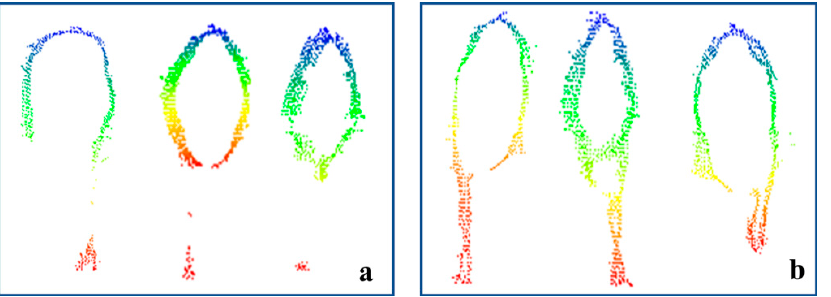
Figure 9. The longitudinal slices of beef cattle point clouds with the inflated and calibrated bound- aries of the same leg regions. ( a ) The slice with the broadened width, ( b ) the slice with the desired width). Herein, the point cloud slices at the boundary of the leg region were first extracted, and the DBSCAN algorithm [26] was then used to cluster all the points inside the slices.